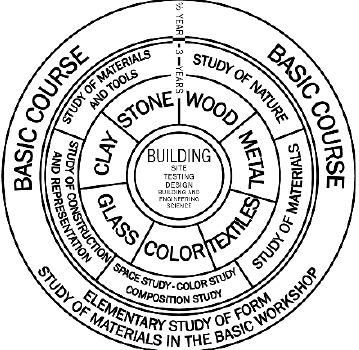
Figure 1. Bauhaus education circle (Makered,